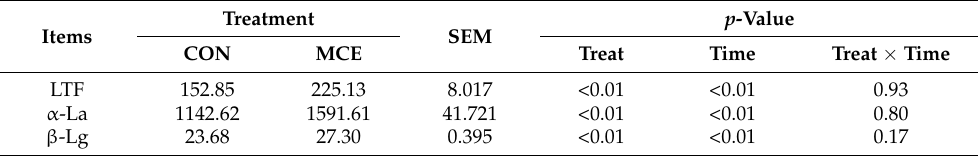
Table 6. Effect of MCE on milk bioactive components ( µ g/mL).